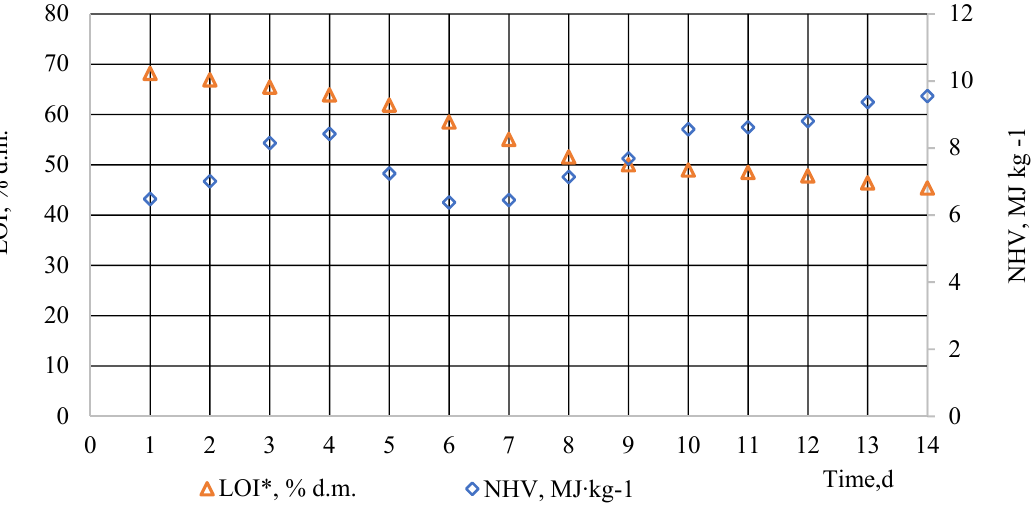
Figure 7. The net heating value and the loss on ignitions registered in the 14 day cycle of the biodrying process. * the LOI is the daily average value recorded from results investigated in the front, middle, and back part of the biodrying reactor.